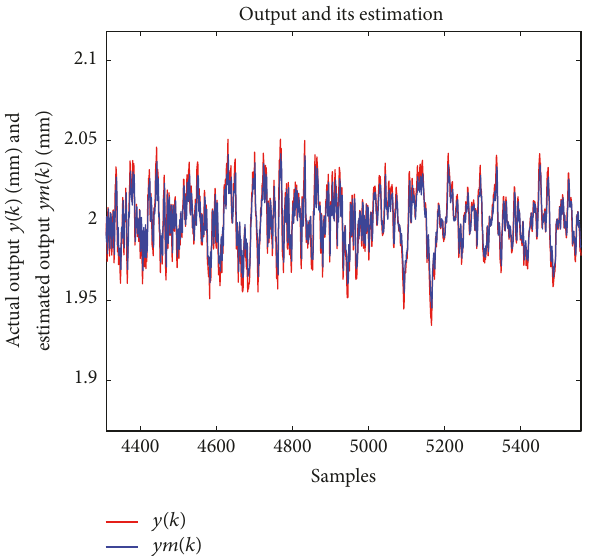
Figure 10: Detailed view of the true and estimated output 𝑦(𝑘) .